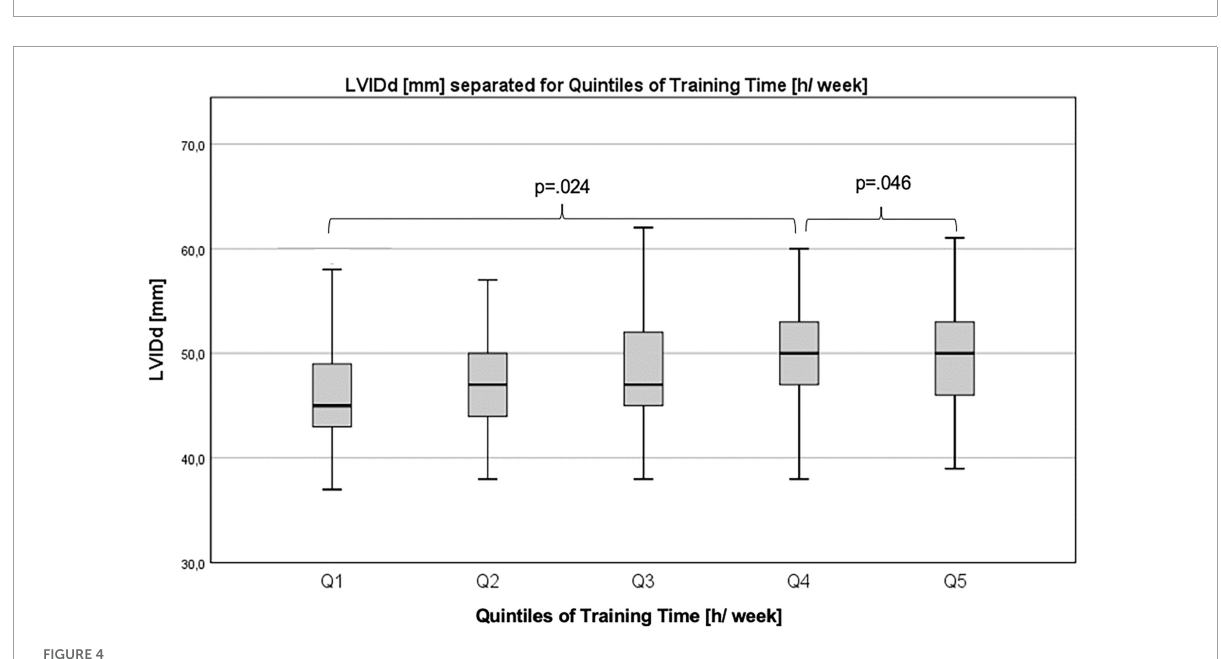
FIGURE3 z-scores for echocardiographic left ventricular parameters.